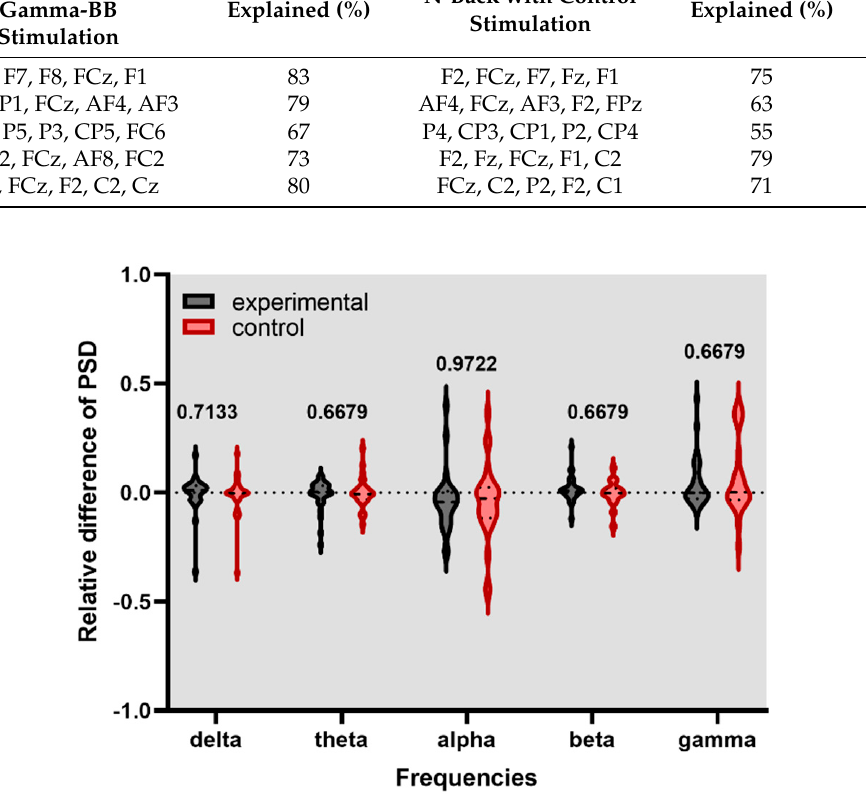
Figure 4. Relative difference of PSD for F2 channel during experimental and control stimulation without a task in a rest state.